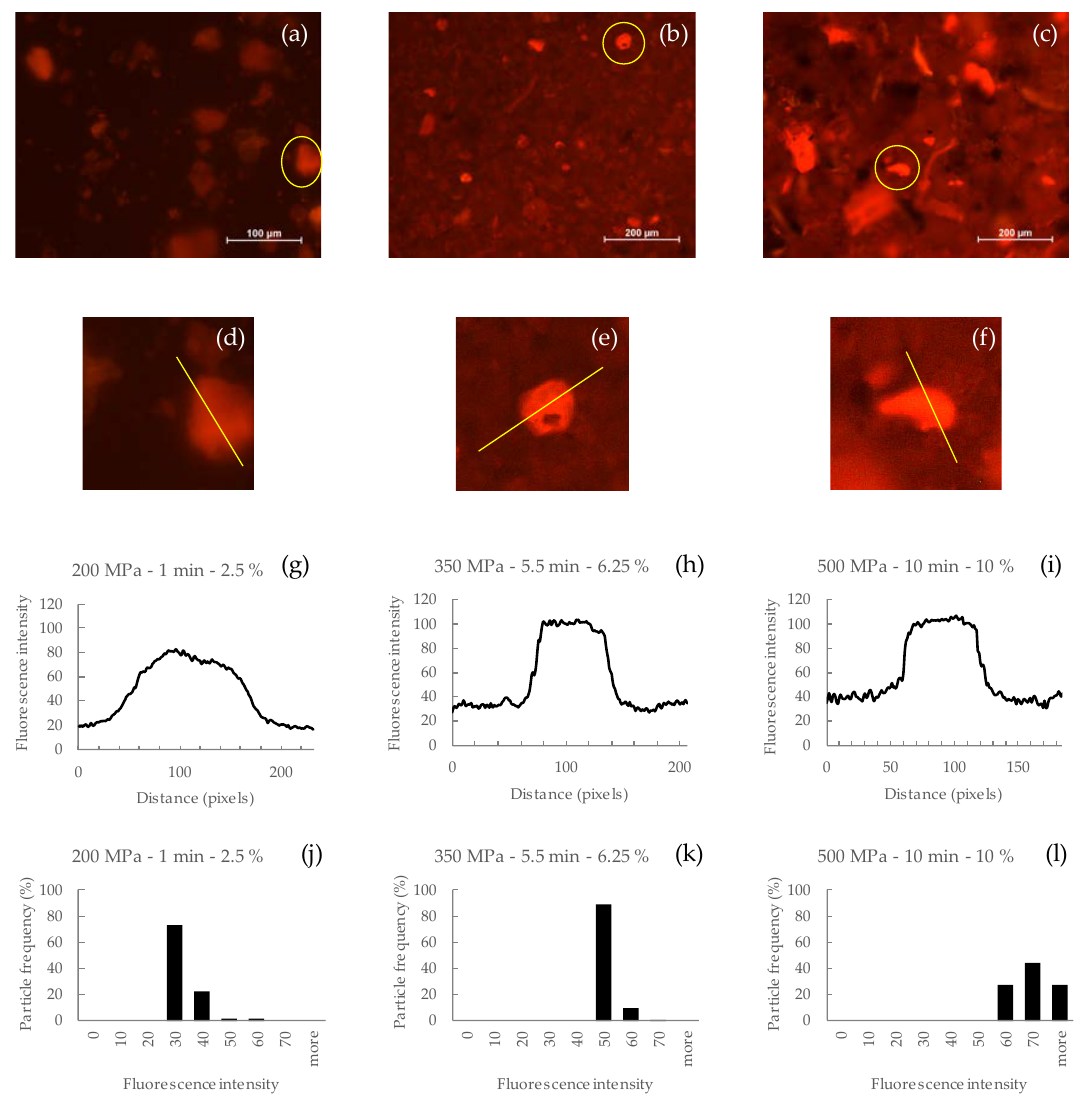
Figure 1. Fluorescence intensity of: 200 MPa, 1 min, 2.5% ( a , d , g , j ); 350 MPa, 5.5 min, 6.25% ( b , e , h , k ); and 500 MPa, 10 min, 10% ( c , f , i , l ).